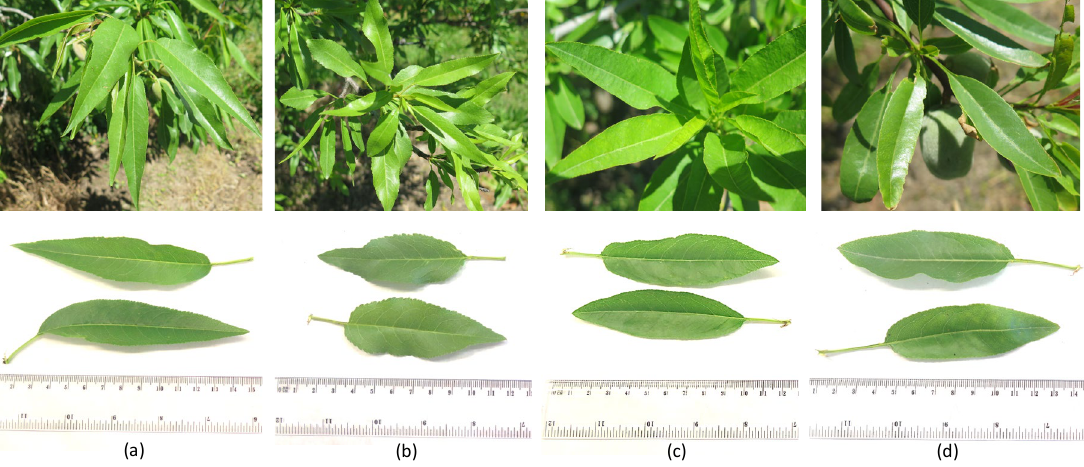
Figure 8. Example of adult leaves in spurs of cultivar Arrubia ( a ), Cossu ( b ), Tuono ( c ), and Texas ( d ), showing different blade shape and